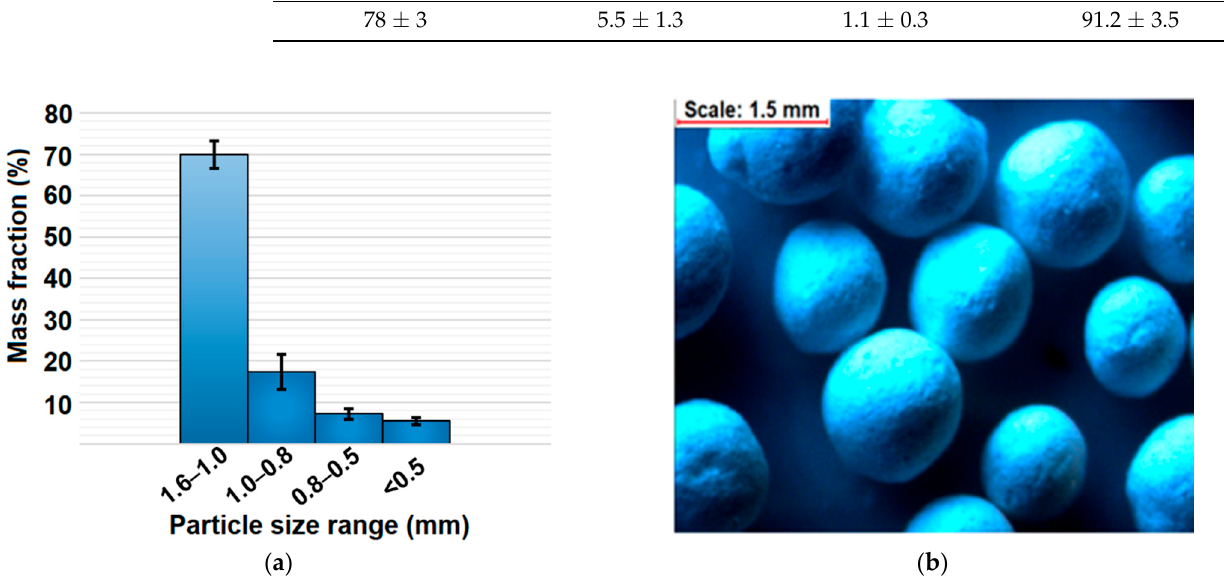
Figure 3. ( a ) Particle size distribution of obtained pellets after sieve analysis; ( b ) stereoscopic view of pellets.